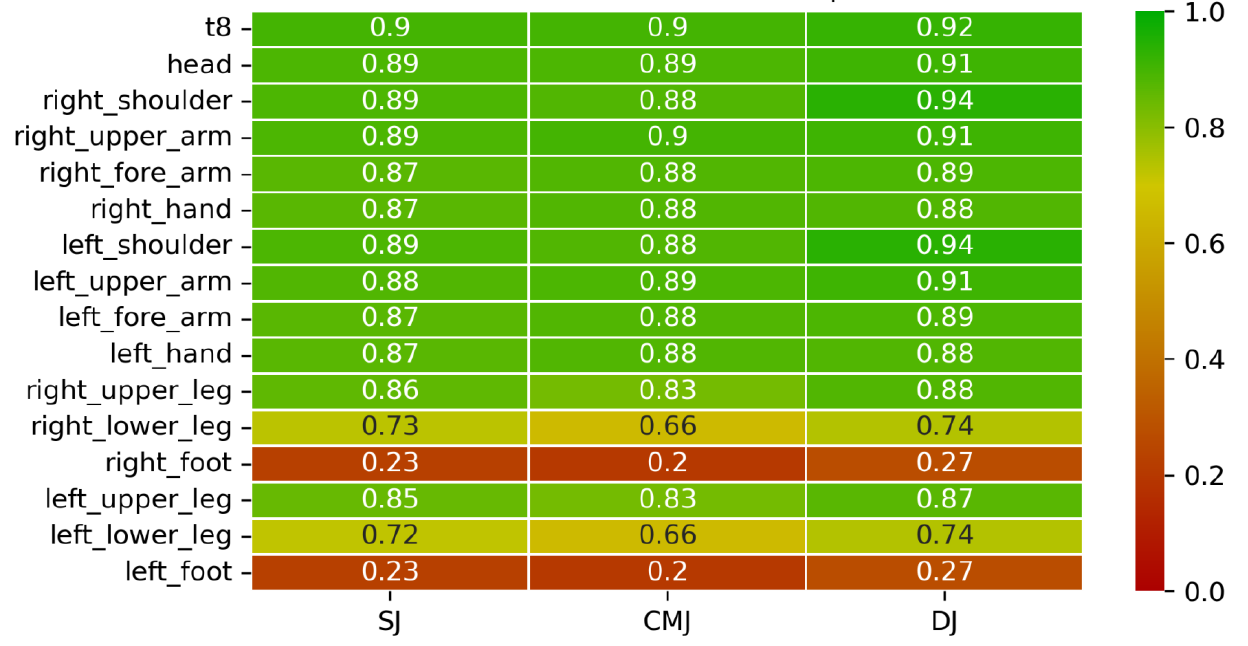
Figure 4. Correlation matrix for the acceleration of the pelvis sensor and one other sensor in gravita- tional direction for SJ, CMJ, and DJ. The values correspond to the correlation of the respective sensor combinations concerning the acceleration curves for each exercise. The color scale underlines the strength of the correlation.